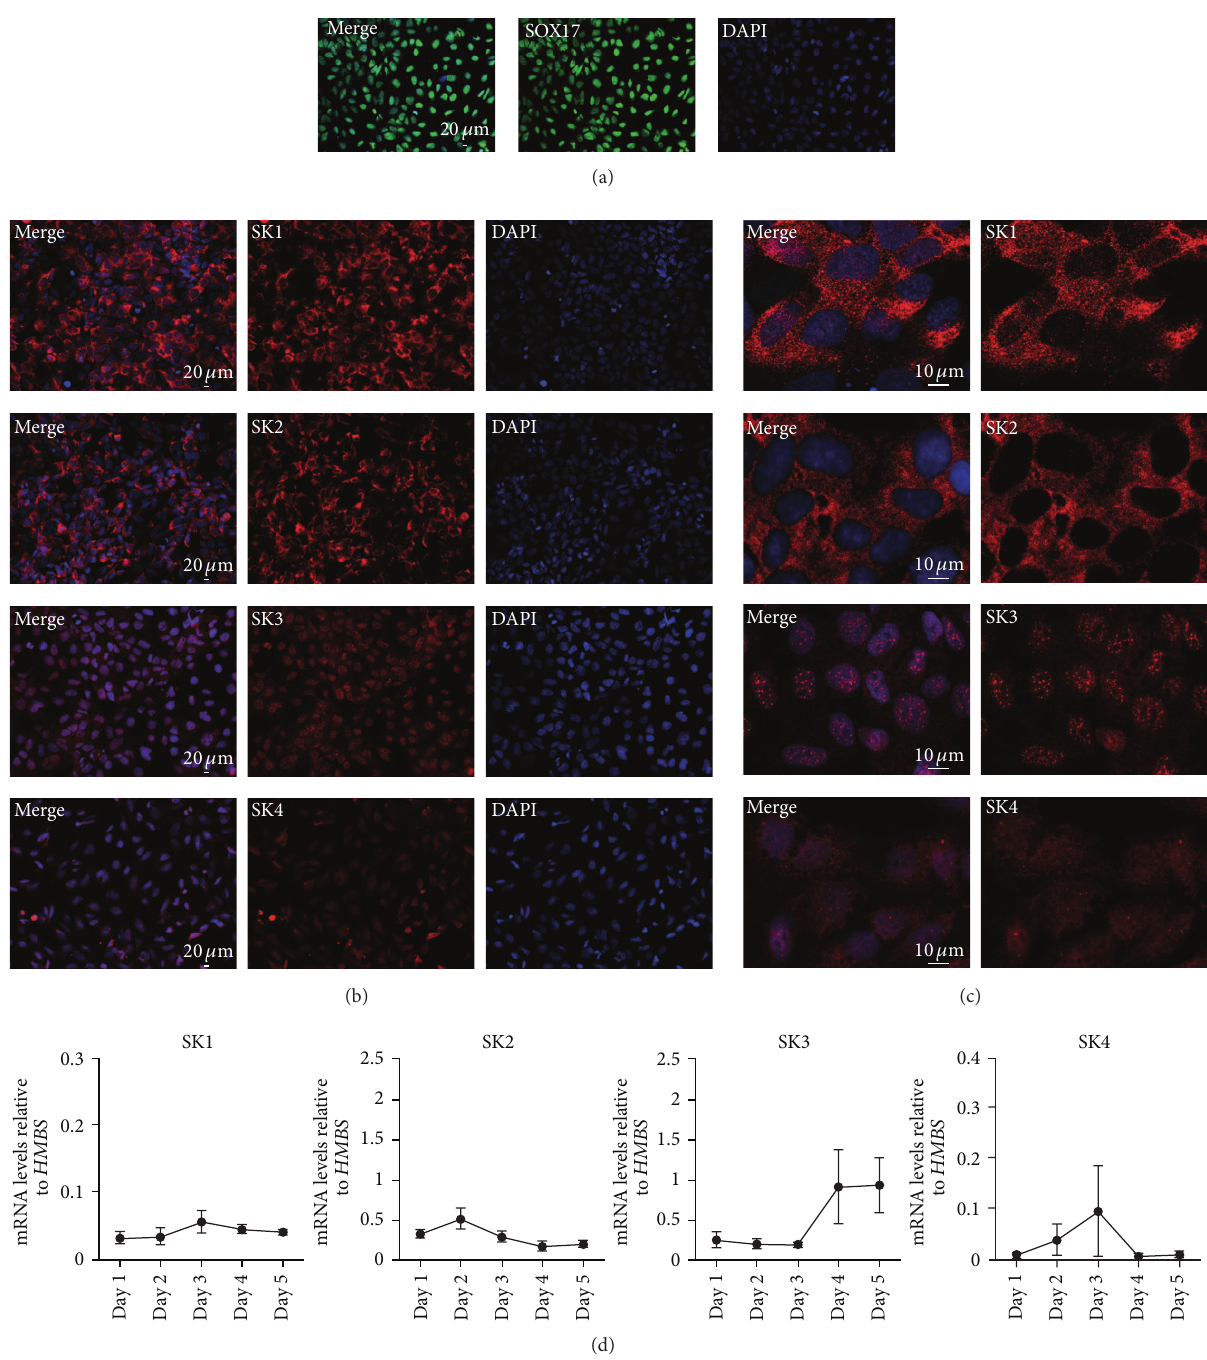
Figure 3: Expression of Calcium-activated Potassium channels during formation of definitive endoderm. (a) Expression of SOX17 ( green ) after 5 days of DE differentiation. (b) Immunofluorescence analysis of SKCa proteins in DE cells. Indicated SKCa subtype ( red) . Scale bars as indicated. (c) Higher magnifications of indicated SKCa subtype ( red) . Scale bars as indicated. (d) Transcript levels of SK1 and SK2 remained relatively low during the DE differentiation. In contrast, mRNA levels of SK3 increased after 4 days of differentiation. SK4 mRNA levels slightly increased during the first days of differentiation and peaked on day 3 followed by a sharp decrease until day 5. Expression levels are shown relative to the housekeeping gene HMBS ( 𝑛 = 4 , two different hiPSCs